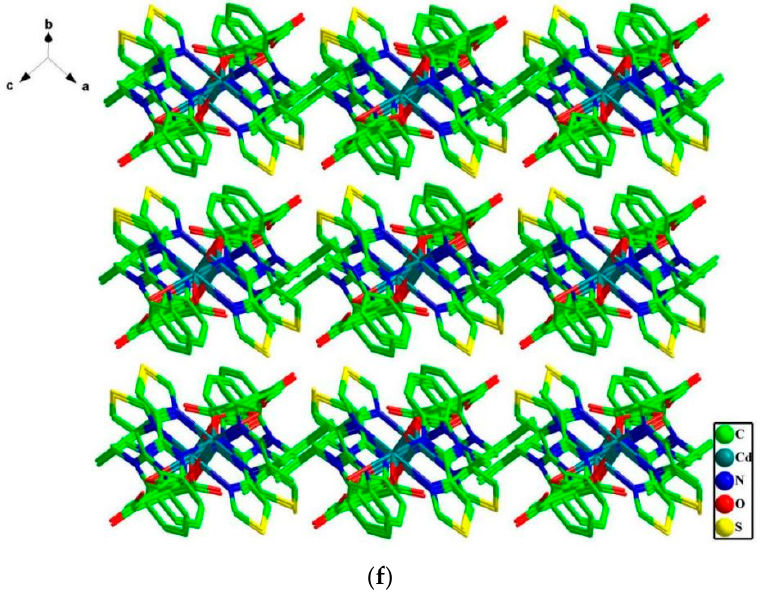
Figure 1. ( a ) Coordination environment diagram around the Cd(II) center in 1 . ( b ) The 26-membered rings constructed by two dbtdb ligands and two Cd atoms. ( c ) The 16-membered rings constructed by two 1,2,4-H 3 btc ligands and two Cd atoms. ( d ) Chain structure of 1 . ( e ) 2D layers of 1 . ( f ) 3D supramolecular structure of 1 .